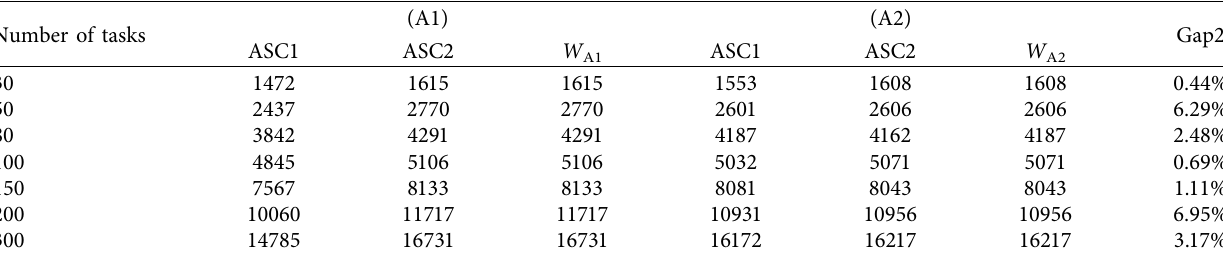
Table 4: Comparisons among (A1) and (A2).